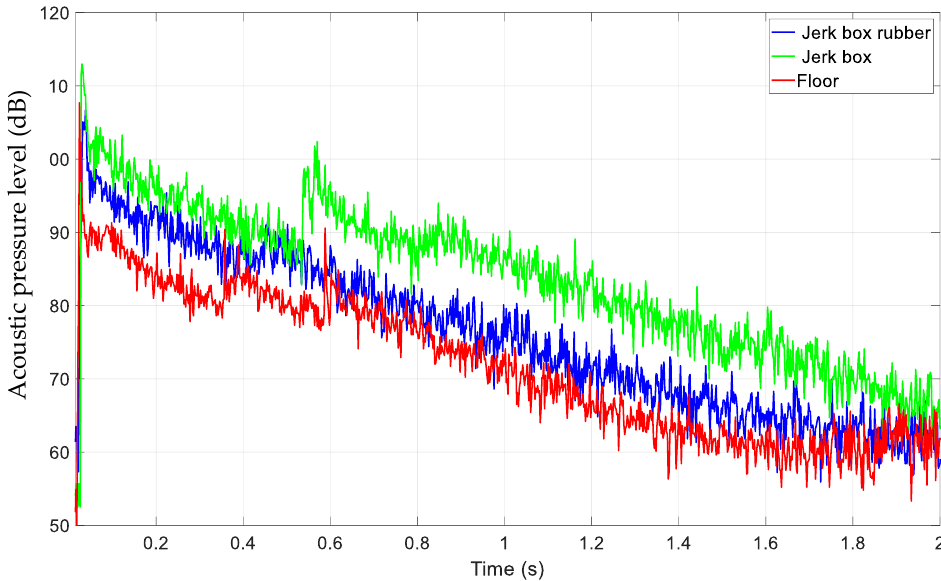
Figure 6. Acoustic pressure level decay registered for different types of barbell impact excitation.